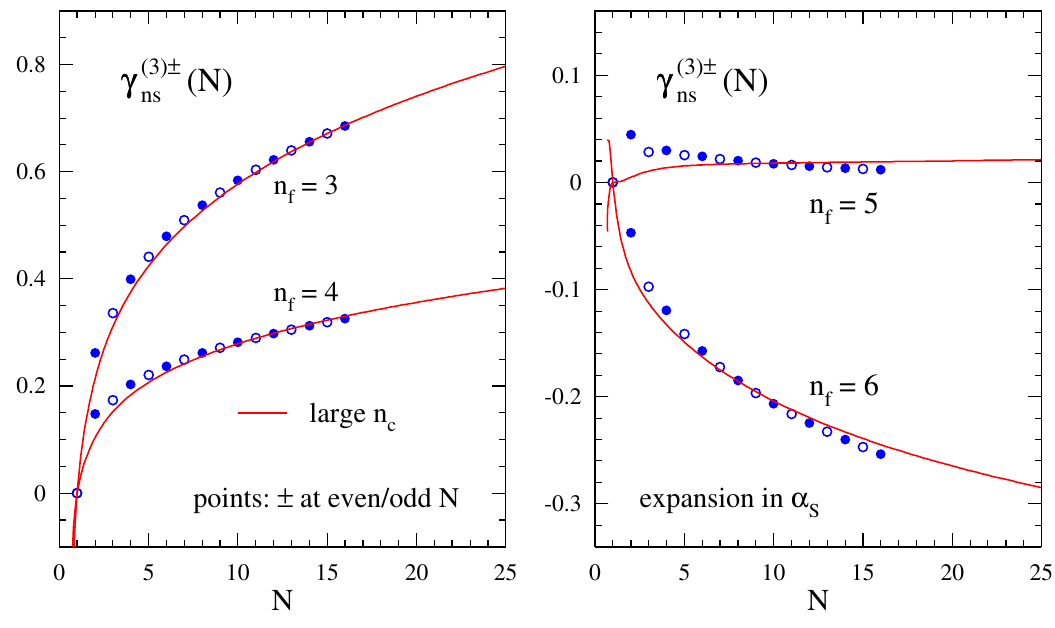
Figure 4 . Our even- N results for (cid:13) ( n )+ ns ( N ) and odd- N values for (cid:13) ( n ) (cid:0) ns ( N ) at n compared with their common large- n c limit now known at all N . The results have been converted to an expansion in (cid:11) s